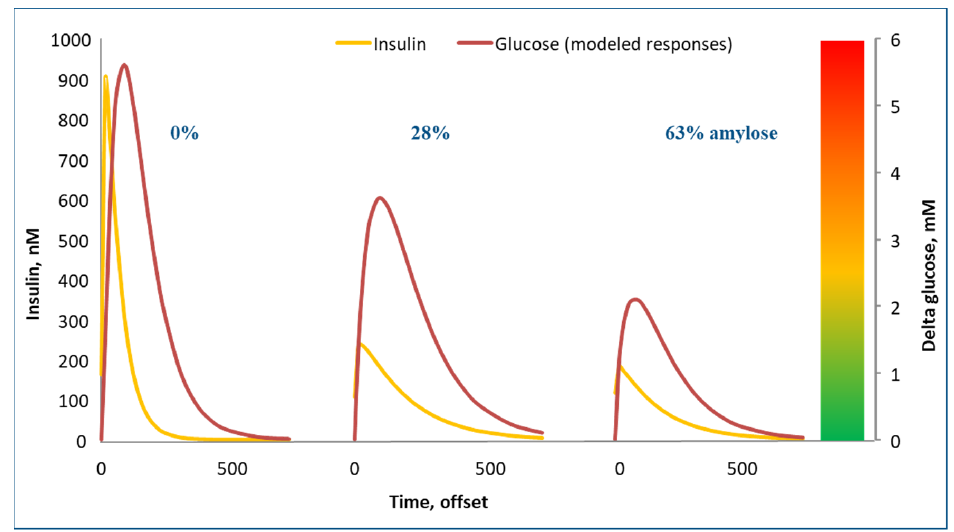
Figure 5. Glucose (mM above baseline) and insulin (nM) response to standardized meals in pigs fed diets varying in amylose content of starch (diets themselves were 70% starch) [16,17]. The colored bar is a subjective attempt to indicate how safe the various increases in levels of blood glucose over baseline are.